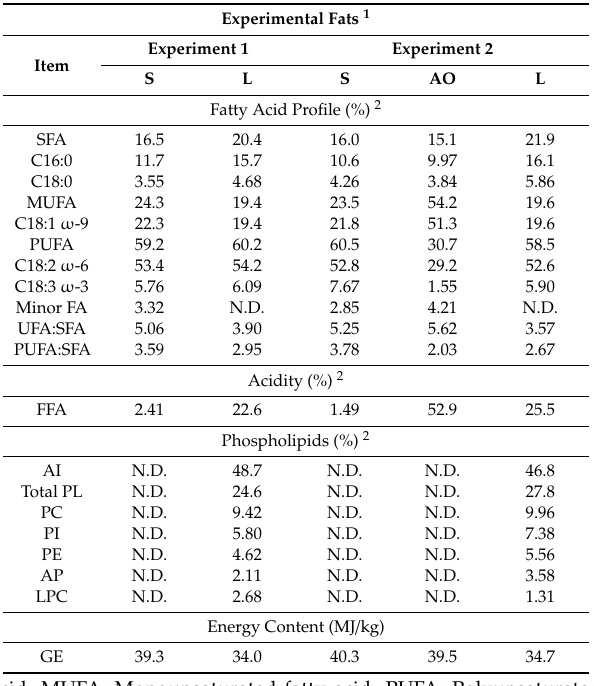
Table 2. Chemical analysis of the experimental added